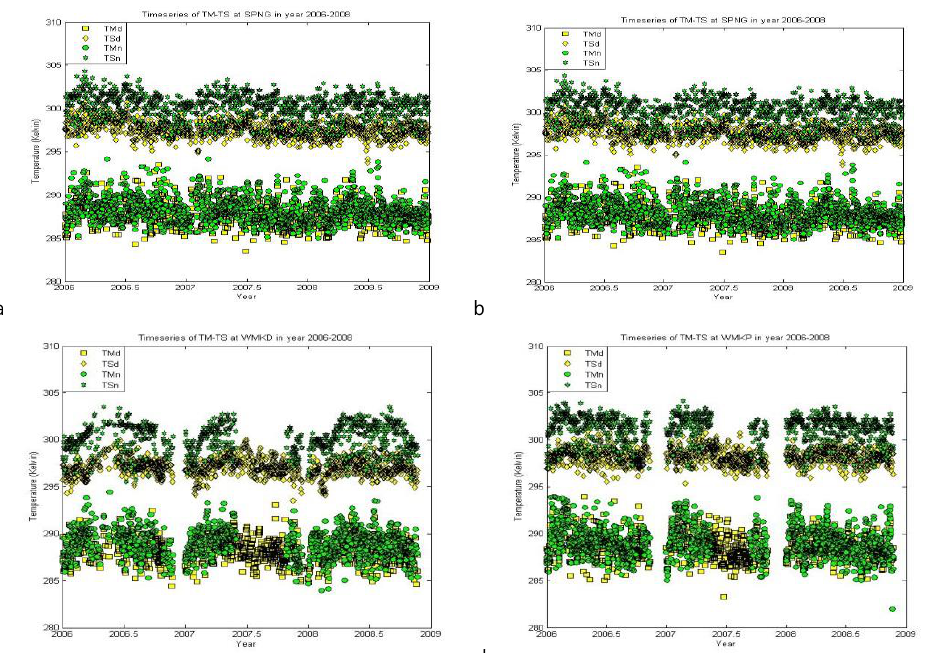
Figure 2. The time-series of T M and T S at SPNG (a), WMKC (b), WMKD (c) and WMKP (d). The TS is higher about 10K compared to the T M . From this figure, it can be clearly seen that observed TS at nighttime is higher than daytime. Meanwhile, no different found in T M between daytime and nighttime.